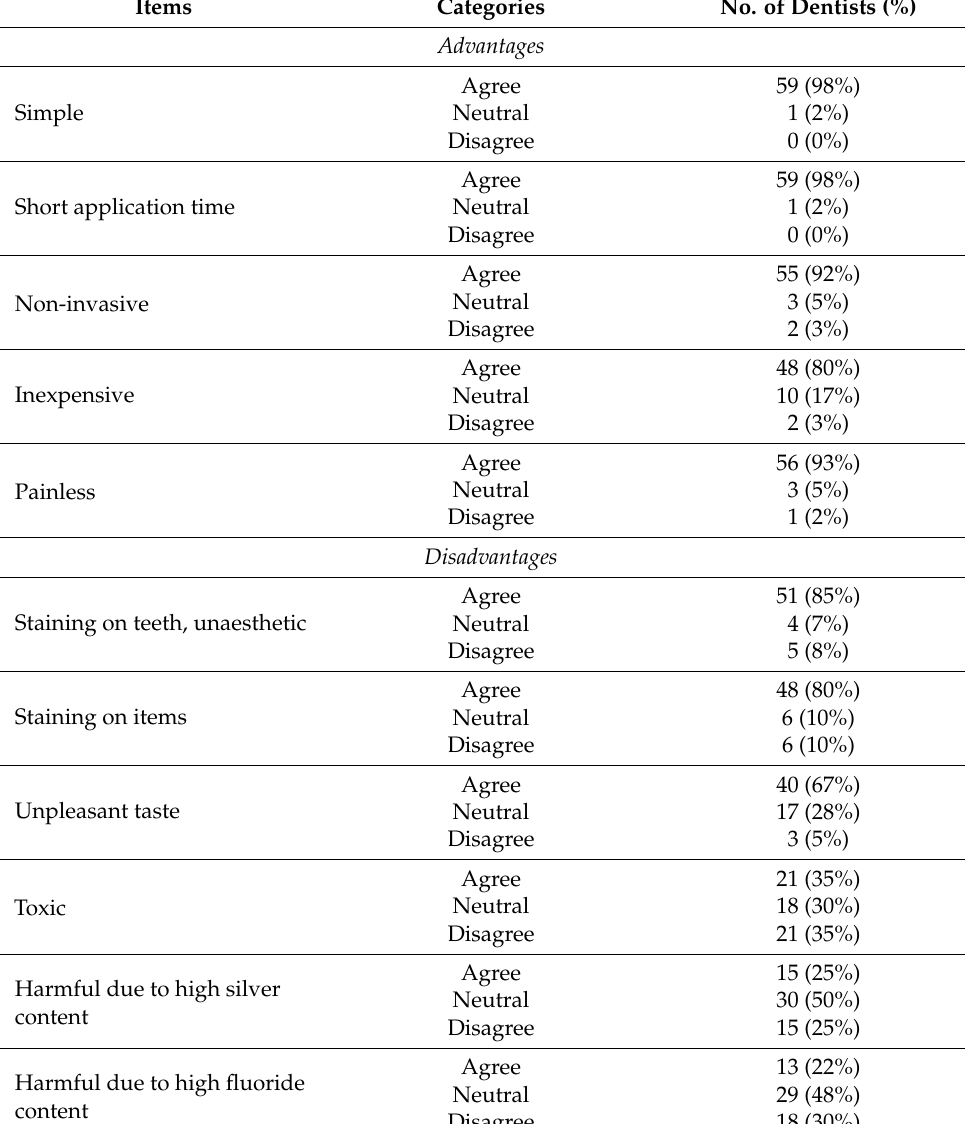
Table 4. Dentists’ views on the advantages and disadvantages of SDF therapy ( n = 60). Items Categories No. of Dentists (%)